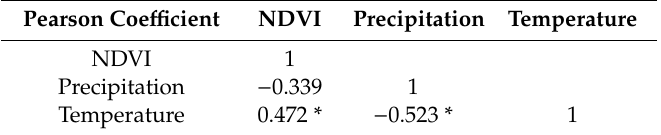
Table 2. The Pearson coefficient between NDVI and climate factors in the growing season. Pearson coefficient NDVI Precipitation Temperature NDVI 1 Precipitation − 0.339 1 Temperature 0.472* − 0.523* 1 Note: * represents the significance level of 0.05.